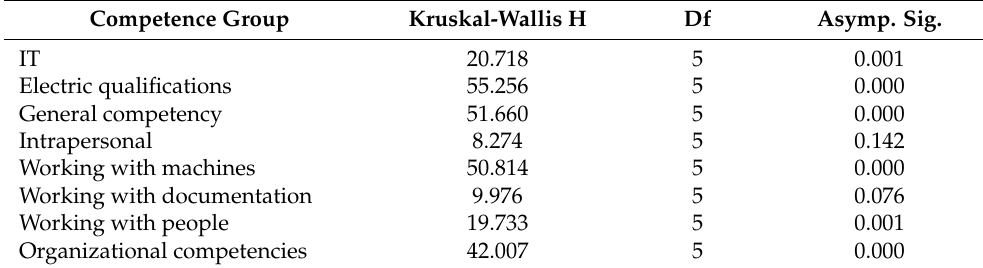
Table 14. Levels of a position.